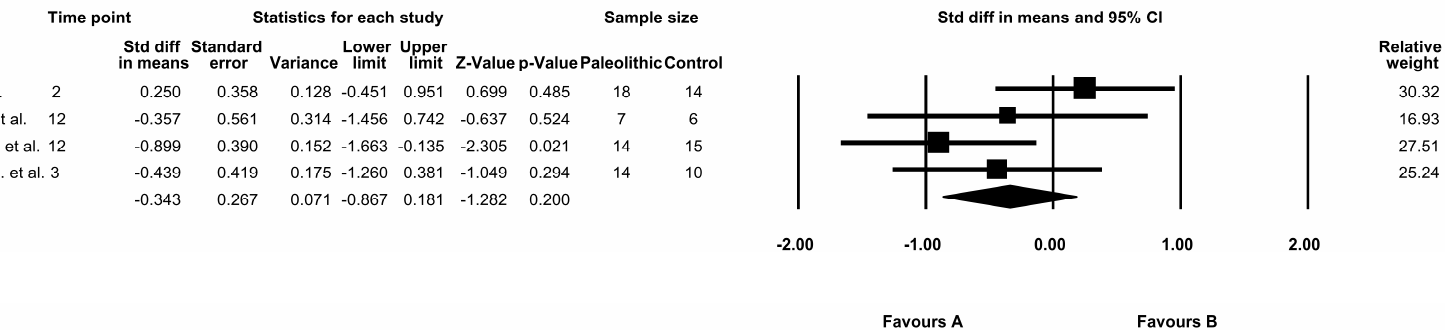
Figure 2. Forest plot comparing fasting glucose levels between the diets (favors A—Paleo group; favors B—control group).